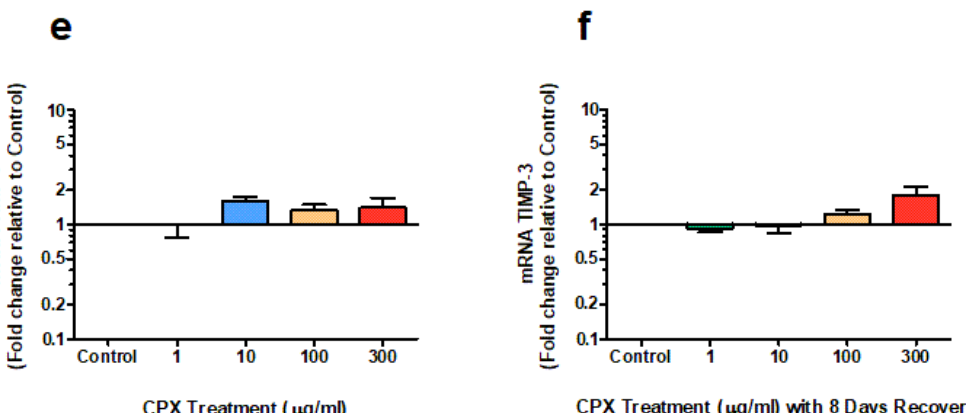
Figure 5. m RNA expression of TIMP-1 ( a , b ), TIMP-2 ( c , d ) and TIMP-3 ( e , f ) after 4 days treatment with 1, 10, 100 & 300 µg/mL CPX and subsequent 8-day recovery period in equine derived tendon explant cultures (n = 4). Results are expressed logarithmically. Values represent mean ± SEM and are expressed as fold change relative to control, normalised to GAPDH. * p < 0.05, ** p < 0.01 vs. control.